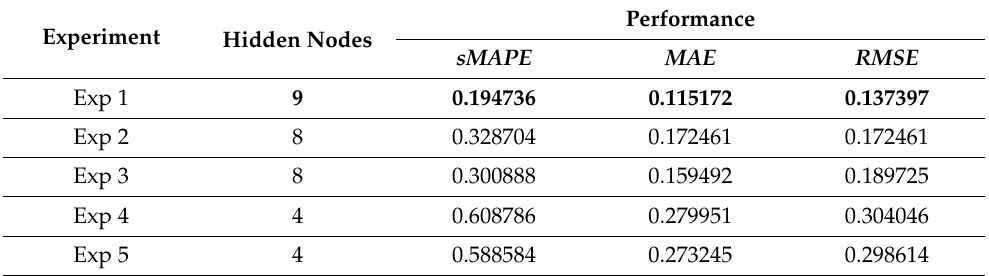
Table 5. DBN experiments results.